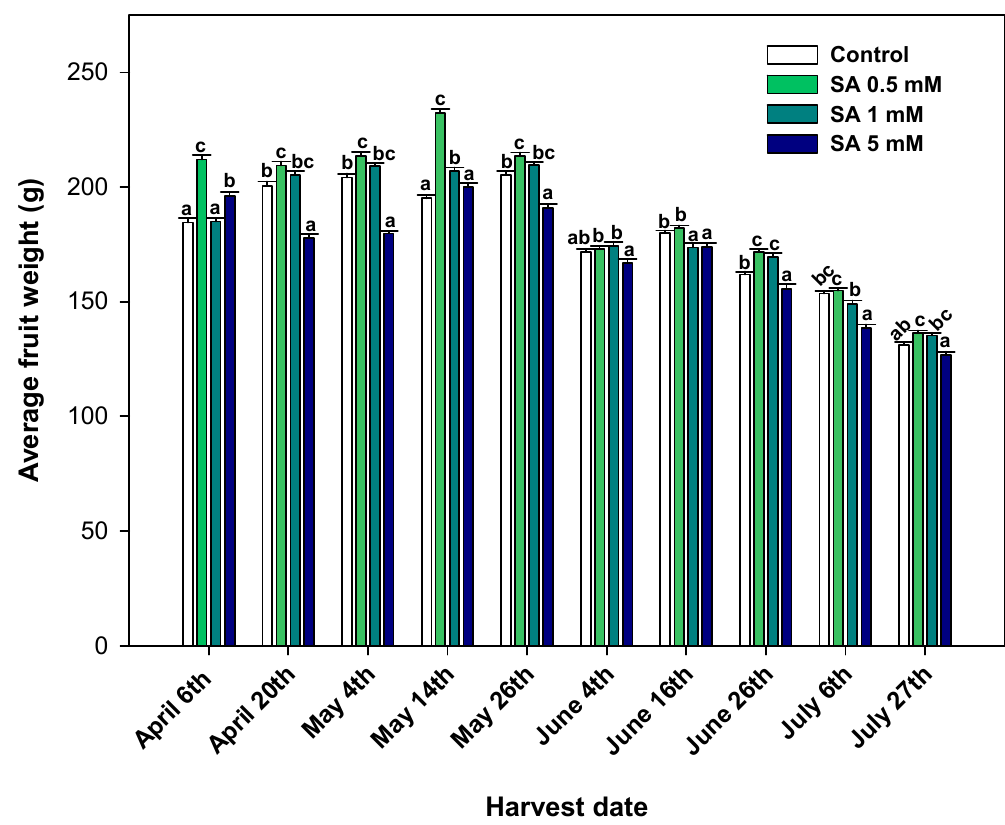
Figure 3. Average fruit weight (g) throughout the developmental and growth cycle of green pepper fruit as affected by salicylic acid (SA) preharvest treatment at 0.5, 1 and 5 mM in the 2020 experiment. Data are the mean ± SE. Different lowercase letters show significant differences among treatments for each harvest date at p < 0.05.